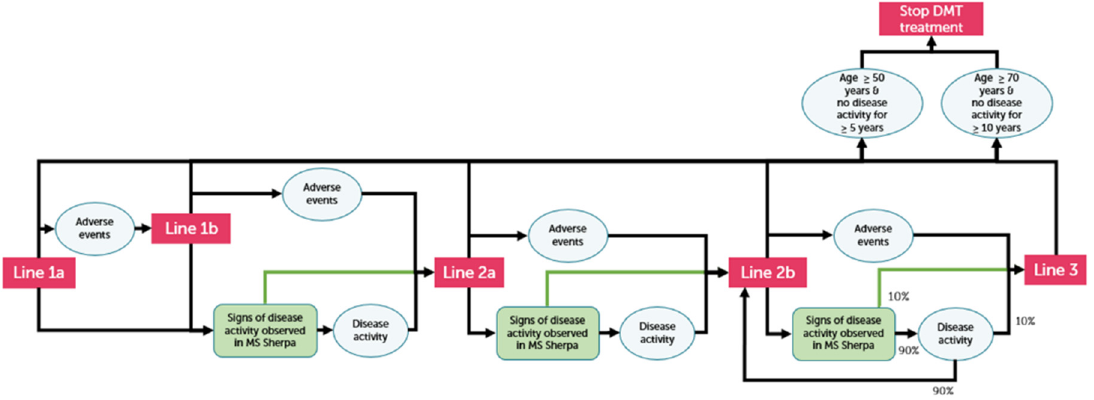
Figure 2. Schematic representation of the MS model.